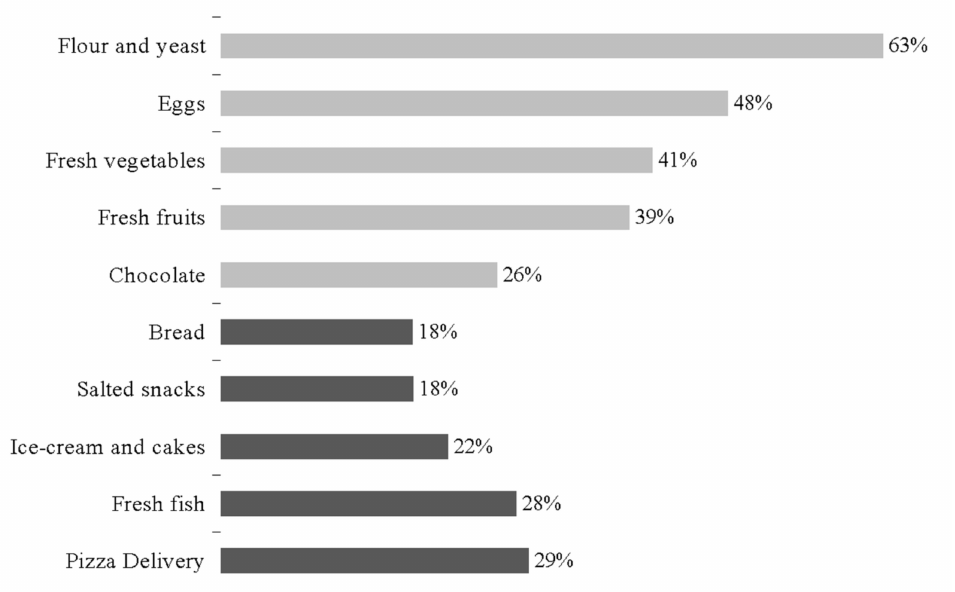
Figure 1. Top five increased (light grey) and top five decreased (dark grey) foods